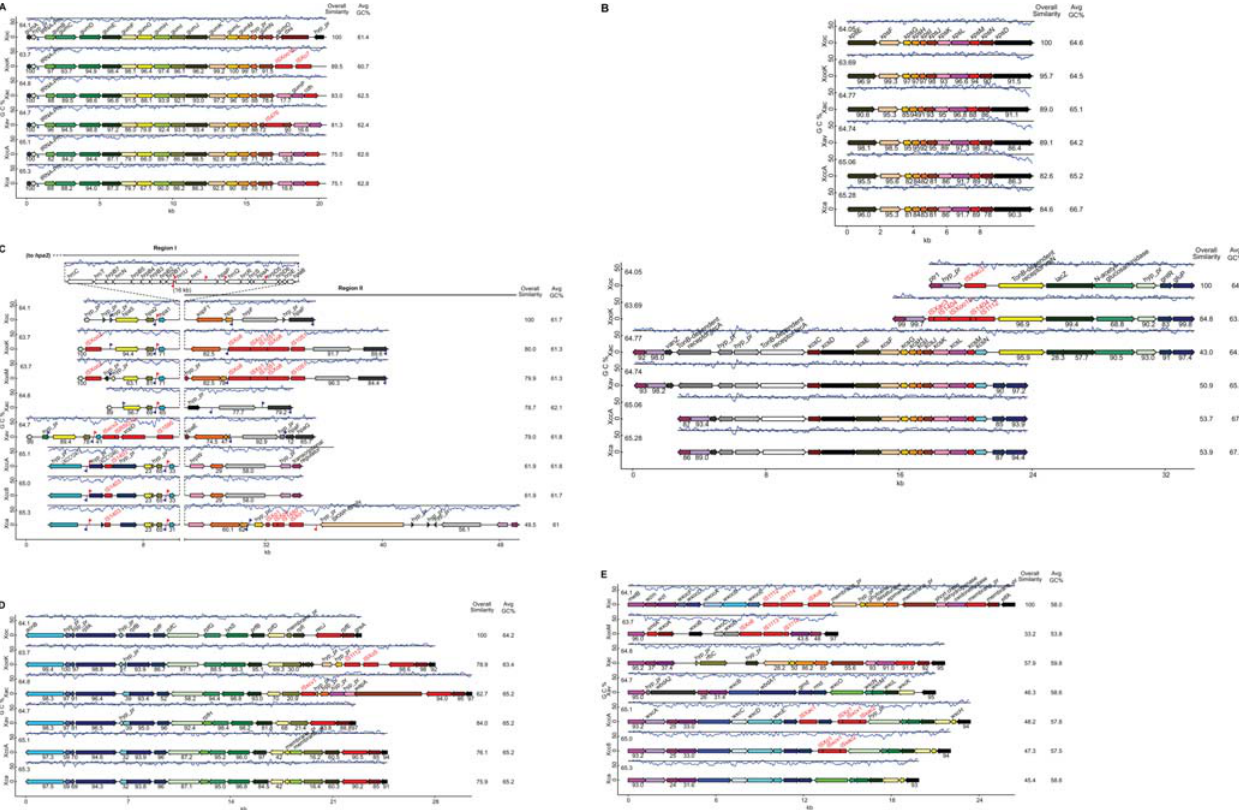
Figure 1. Comparison of six clusters of genes involved or implicated in pathogenesis among Xanthomonas strains representing three species and six pathovars. Sequences of X. oryzae pv. oryzicola strain BLS256 (Xoc), Xanthomonas oryzae pv. oryzae KACC100331 (XooK) and MAFF311018 (XooM), X. axonopodis citri strain 306 (Xac), X. axonopodis pv. vesicatoria strain 85-10 (Xav), X. campestris pv. campestris strains ATCC33913 (XccA) and 8004 (Xcc8), and X. campestris pv. armoraciae strain 756C (Xca) were used. Arrows represent individual genes. For each cluster across genomes, homologs are shown in like colors. Gene identities are given (non-redundantly) above each gene. The blue trace above each cluster represents GC content (window size: 160 bp, step: 40 bp). The black line above each cluster marks the average GC content of the genome, specified below and to the left of the line. Shown for each gene is the percent identity of the predicted product to that of the corresponding gene (if present) in the genome shown at the top. The overall similarity of each cluster to the cluster at the top is given at the near right. The average GC content of each cluster is given at the far right. Where clusters from different strains of the same pathovar are essentially identical, only one is represented. Insertion sequence elements are indicated by red rectangles, tRNA genes by blue triangles and plant-inducible promoter sequences (PIP boxes) by red or blue flags. A red flag represents a perfect PIP box and a blue flag represents an imperfect one. The orientation of the PIP box is represented by the orientation of the flag above or below the cluster. A, the gum gene cluster; B, the xps and xcs gene clusters; C, the hrp gene cluster; D, the rpf gene cluster; E, the lipopolysaccharide biosynthesis gene cluster bordered by the etfA and metB genes.